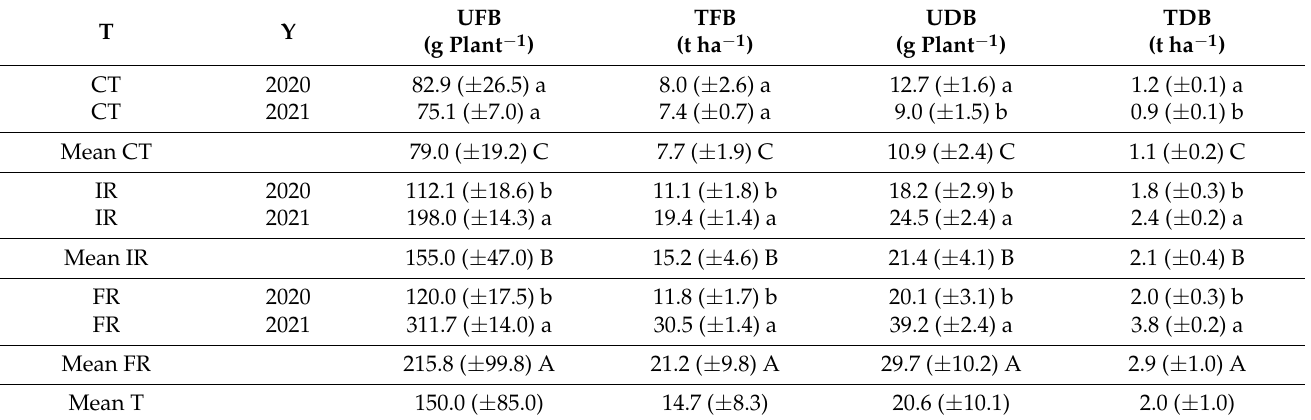
Table 5. Estimated biomass marginal mean differences calculated with the Bonferroni adjustment for two years with the same treatment. Means ( ± standard deviation) within each column followed by different lowercase and uppercase letters are significantly different (ANOVA, p < 0.05) between the two years in the same treatment and among the treatments (by averaging each of the values of the two years),